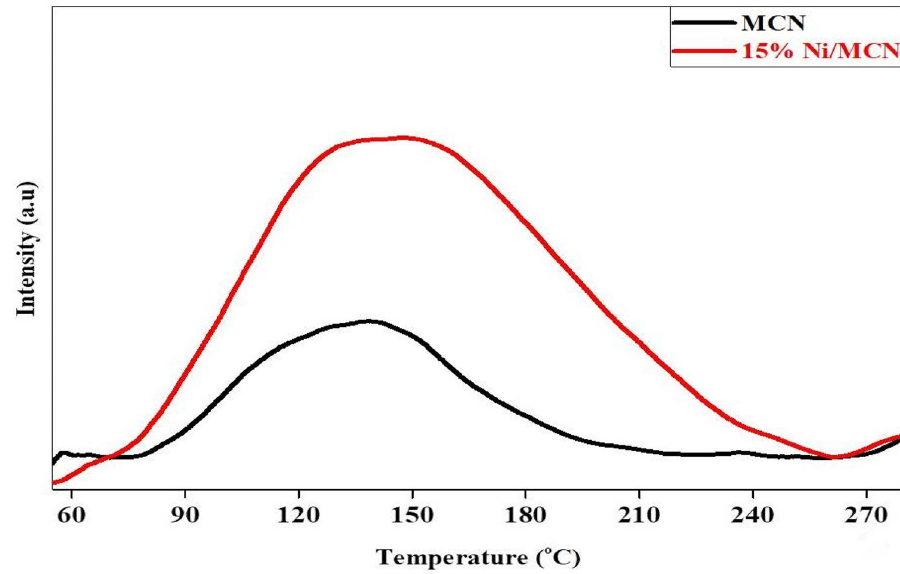
Figure 8. CO 2 -TPD analysis of MCN and 15% Ni/MCN.